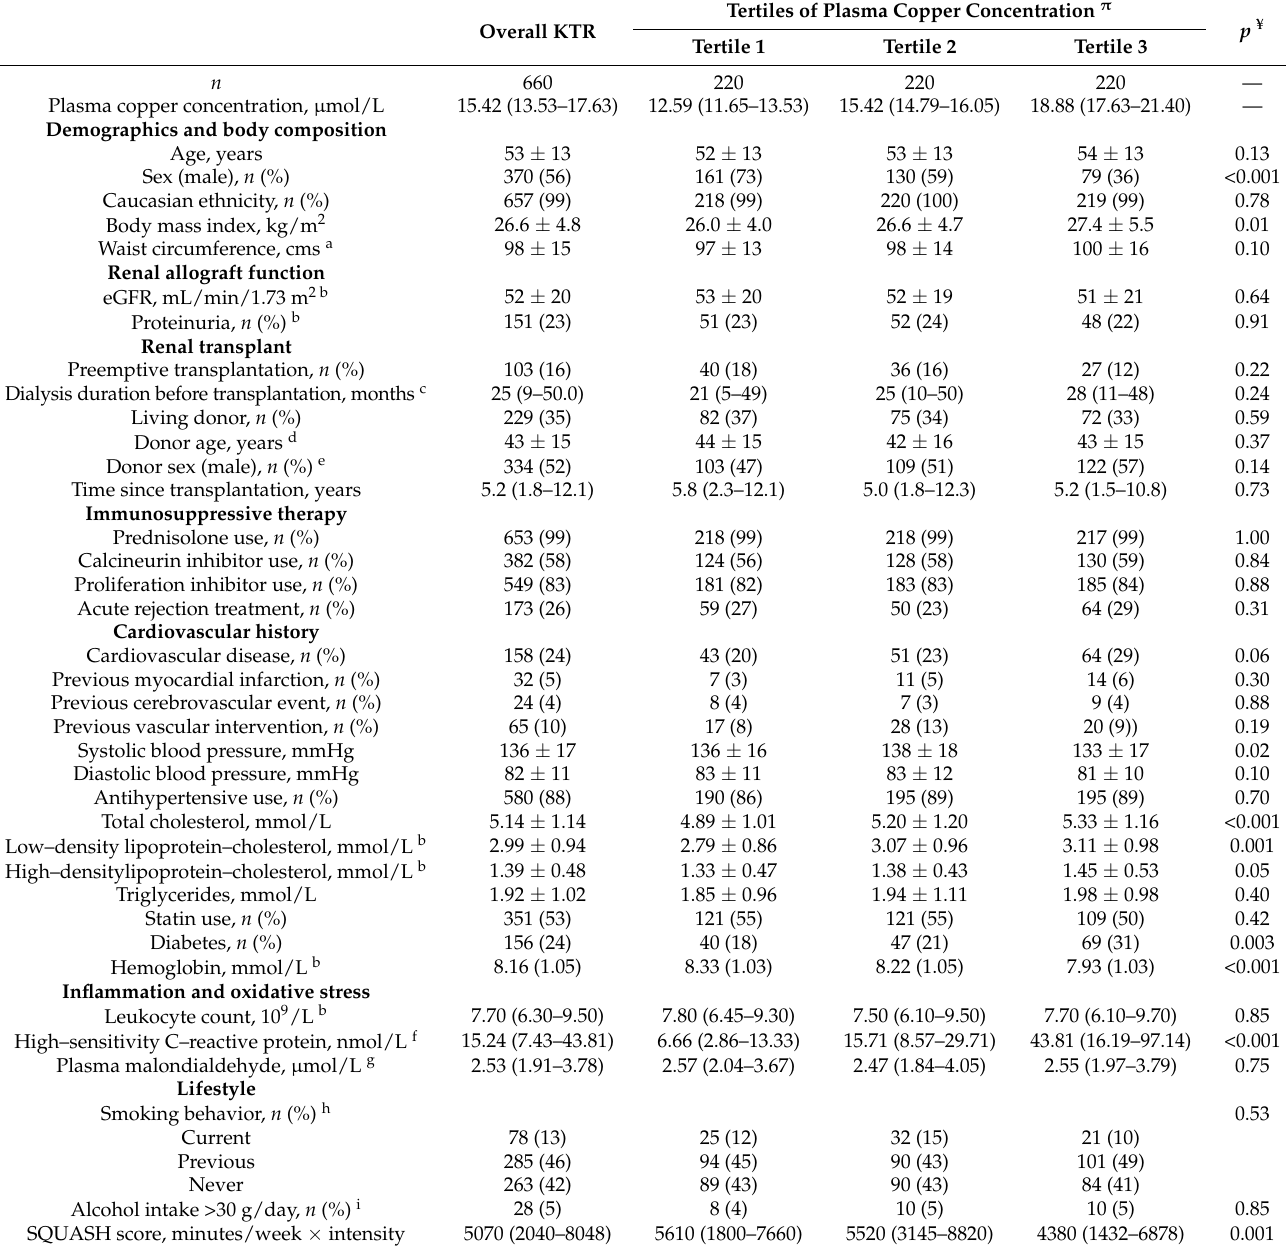
Table 1. Baseline characteristics of